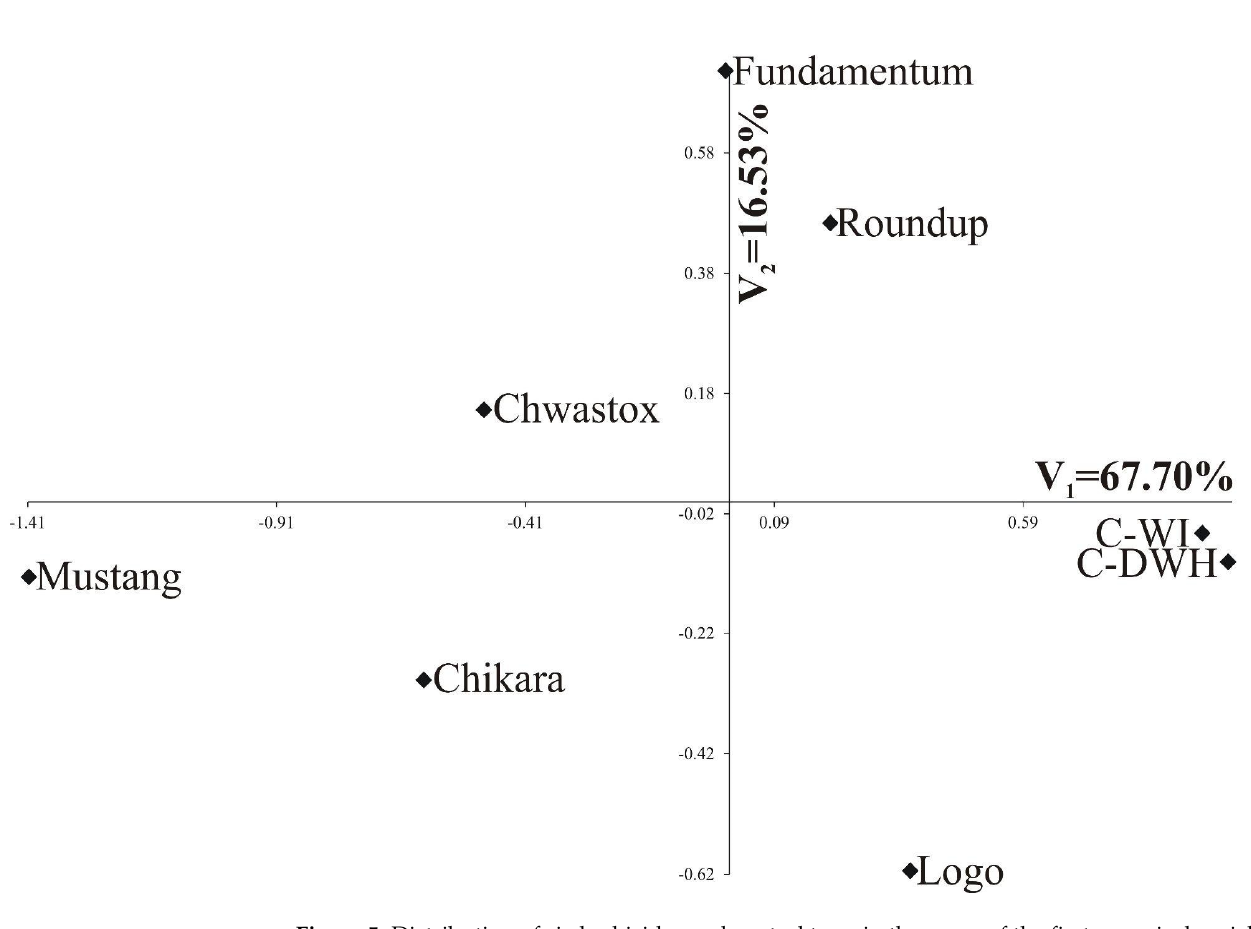
Figure 5. Distribution of six herbicides and control trees in the space of the first canonical variable (V 1 ) and the second canonical variable (V 2 ). Table 3. Correlation coefficients between the first two canonical variates and studied features for herbicides.